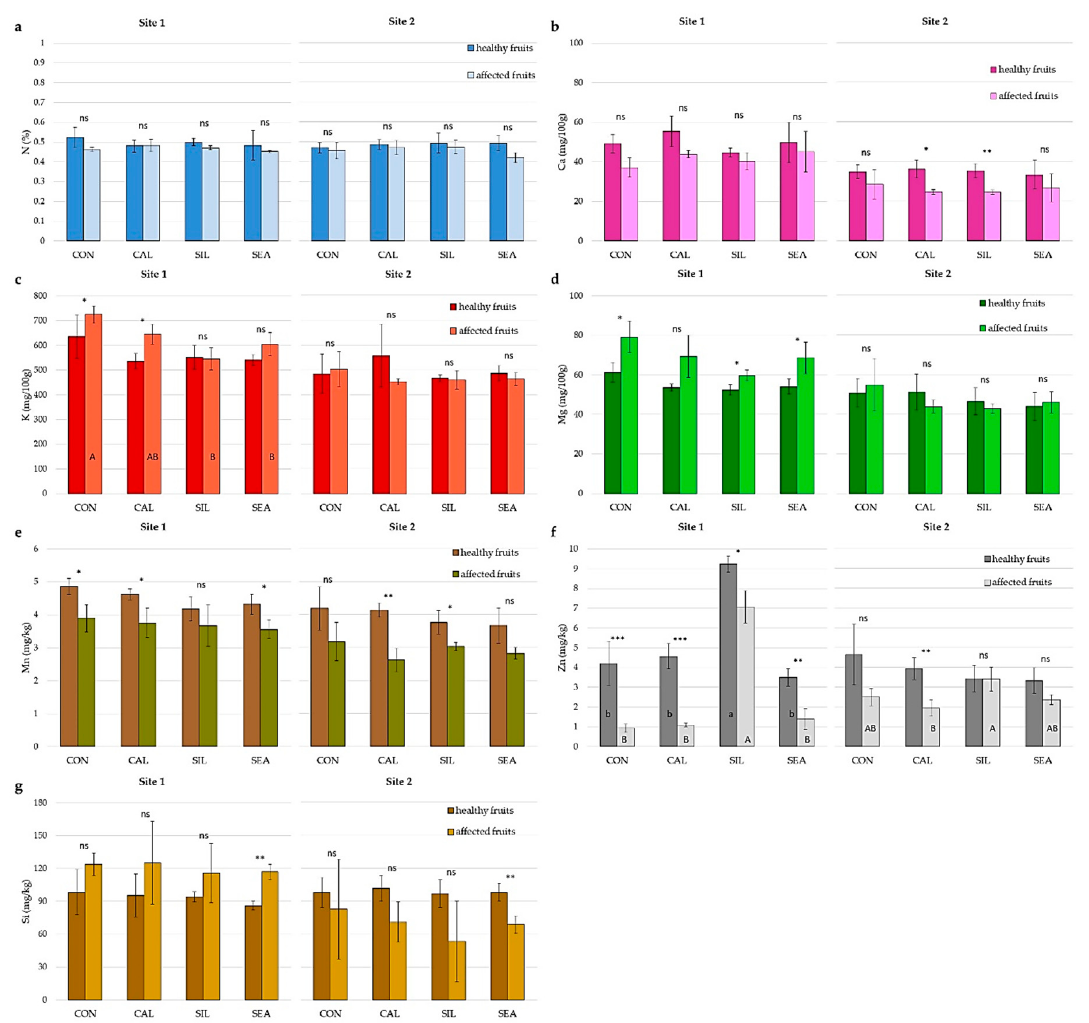
Figure 6. Nitrogen ( a ), calcium ( b ), potassium ( c ), magnesium ( d ), manganese ( e ), zinc ( f ), and silicon ( g ) content in apple skin after storage in healthy and symptomatic fruits in site 1 (left) and site 2 (right). Vertical bars indicate mean ± SD ( n = 3). Asterisk on the top of the bar indicates significant differences according to one-way ANOVA (*** p < 0.001; ** p < 0.01; * p < 0.05; ns: not significant) between healthy and affected fruits. Letters inside bars refer to significant differences among treatments for healthy fruits (lowercase letters) and affected fruits (uppercase letters), according to Tukey’s HSD post-hoc test; p < 0.05.